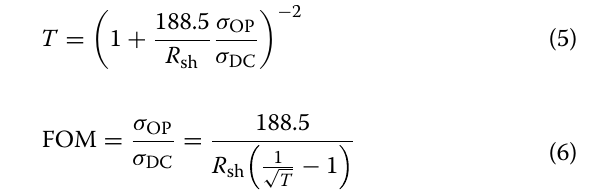
Fig. 5 FESEM images of c‑rGO/CuNWs with a 1 dipping cycle and b 5 dipping cycles. The open spaces between nonuniform c‑rGO layers result in accelerated corrosion of CuNWs. FESEM images of h‑rGO/ CuNWs with c 1 dipping cycle and d 5 dipping cycles. The h‑rGO/ CuNWs with more dipping cycles shows large‑area and uniform coverage of h‑rGO layers on CuNWs surface